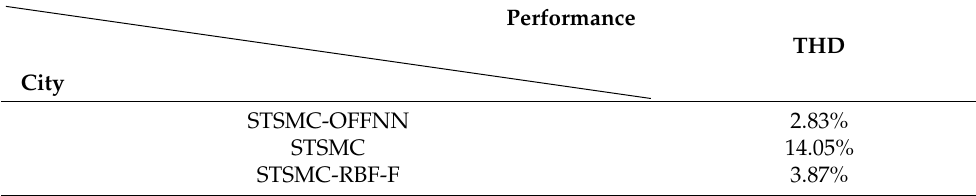
Table 2. Comparison of THD in